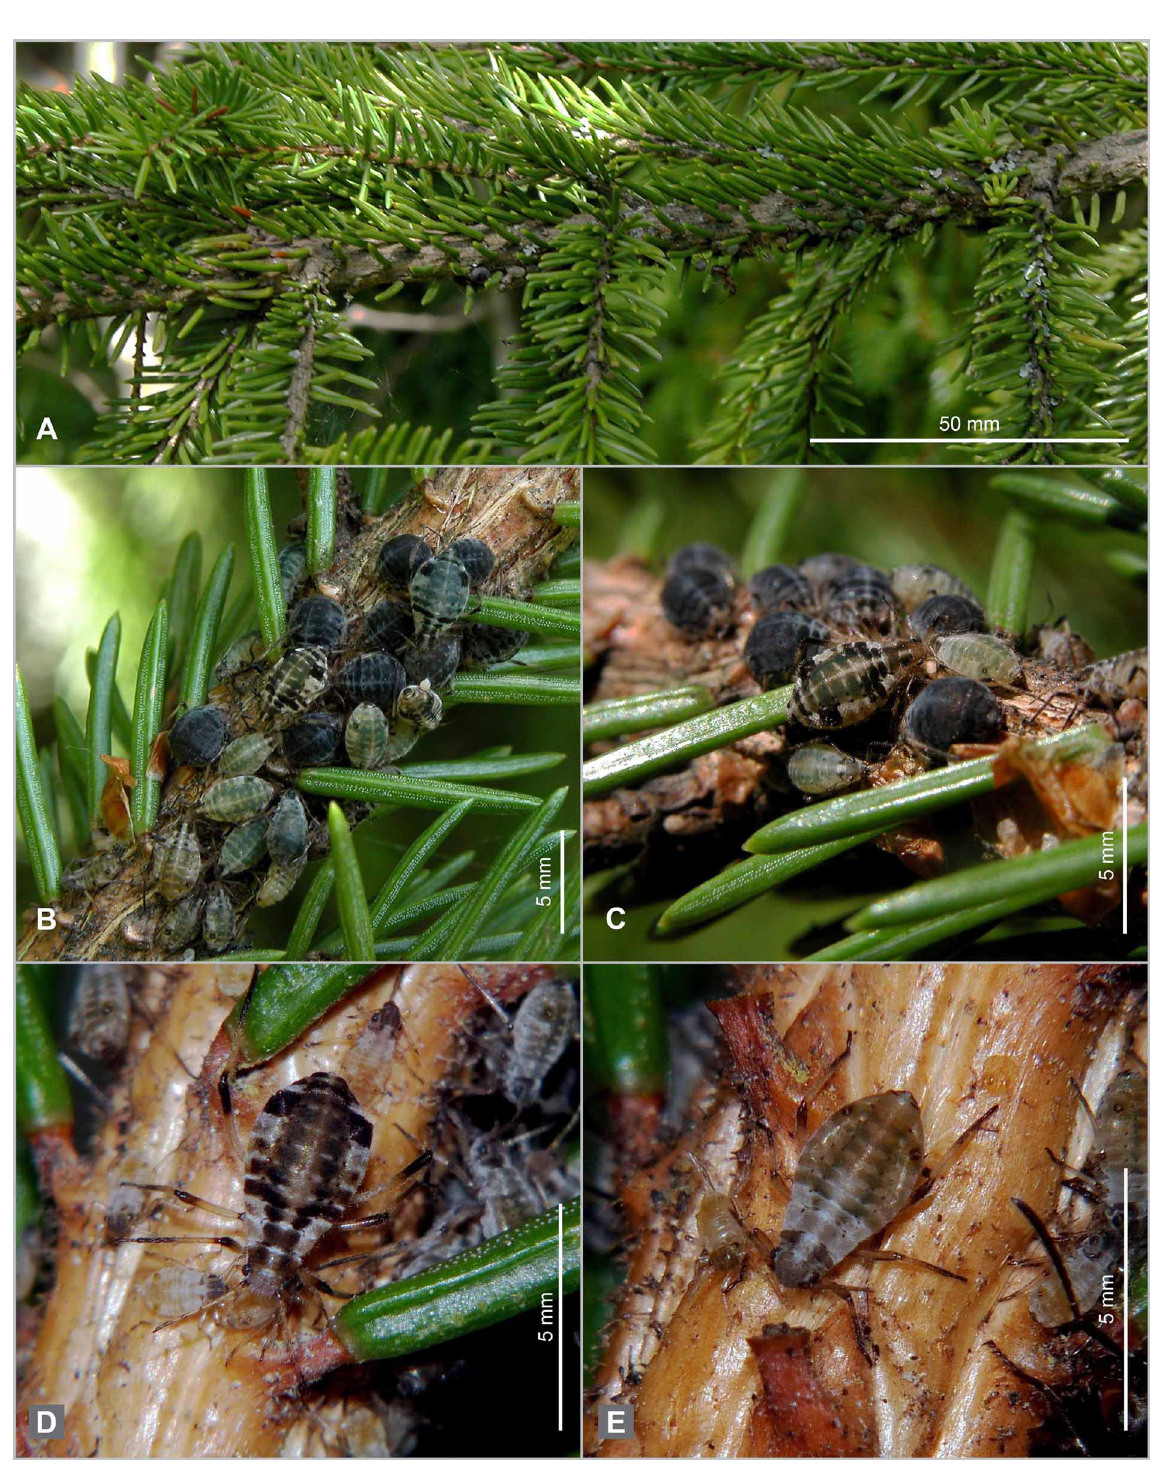
Fig. 36. Cinara (Cinara) pruinosa (Hartig, 1841) on Picea abies . A . Branch with colony and attendant Formica aquilonia Yarrow, 1955 on underside. B–C . Adult and juvenile apterae. The dark individuals are parasitized. D . Adult aptera. E . Full-grown juvenile